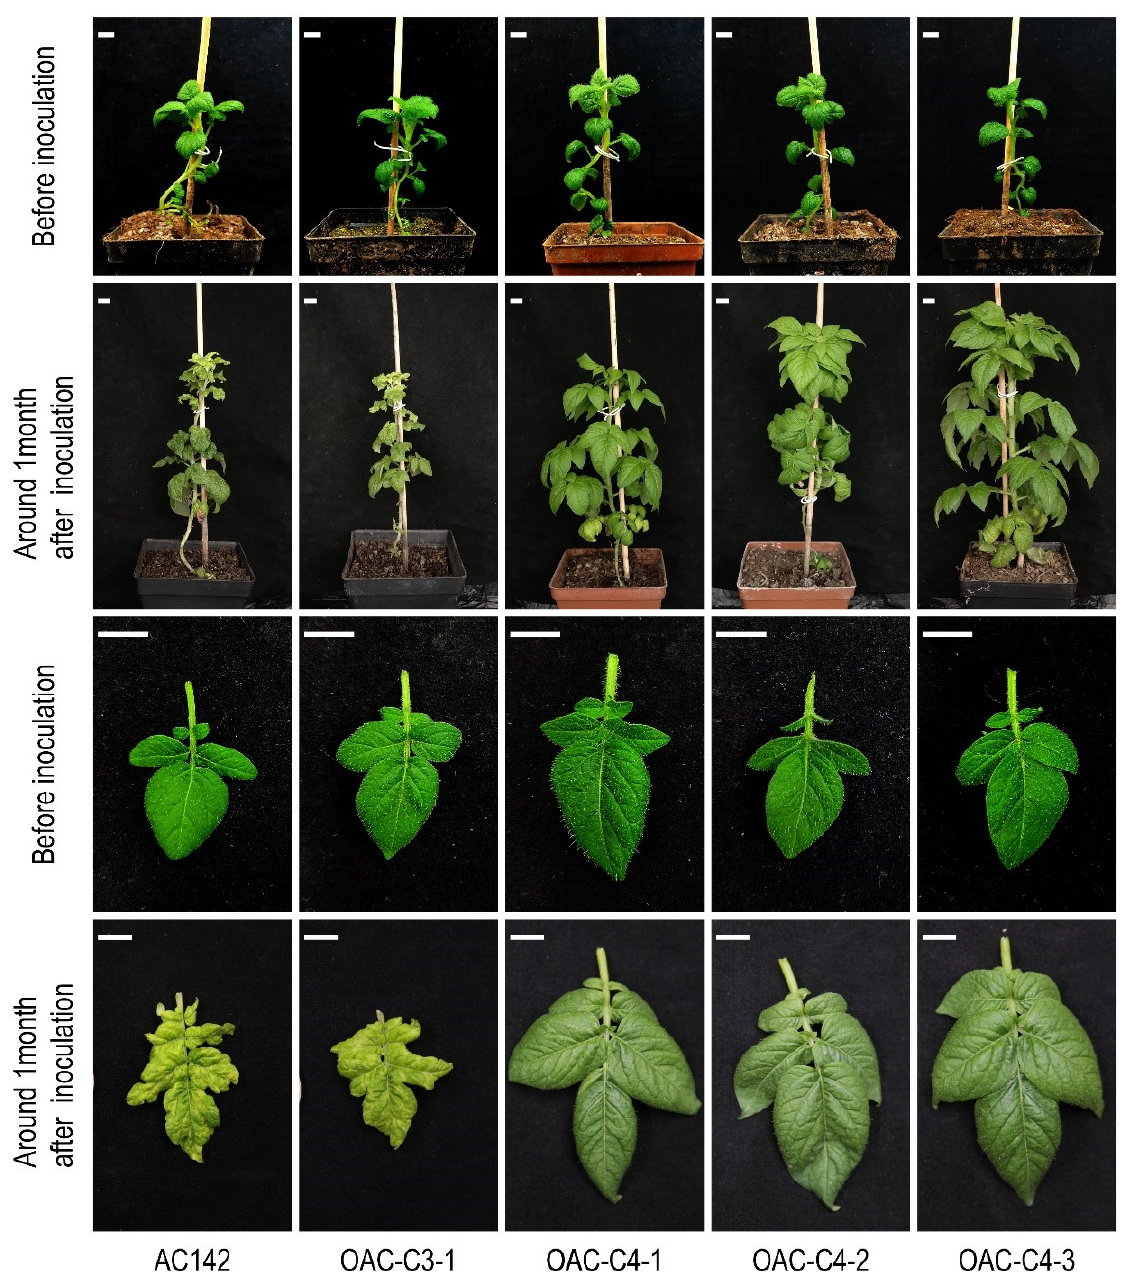
Figure 3. Symptoms of transgenic plants derived from AC142 at approximately 1 month after inoculation with PVY O . Representative plants and leaves are shown.